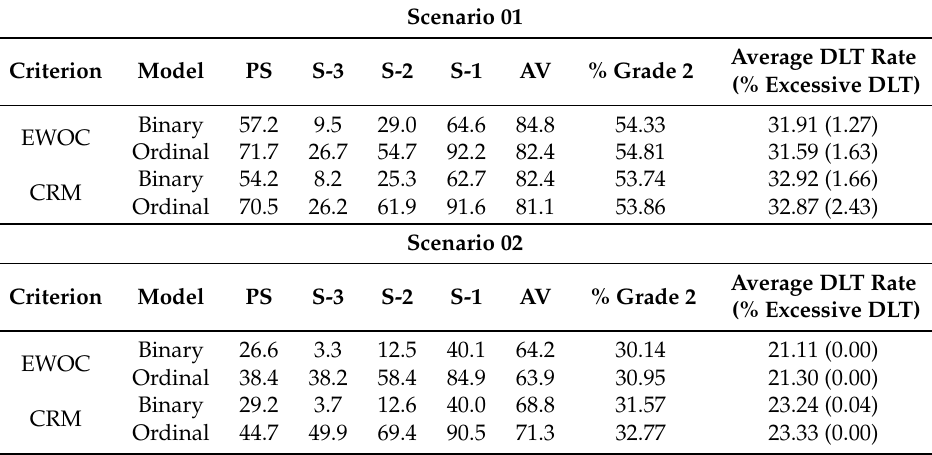
Table 3. Operating characteristics summarizing trial efficiency and safety for CRM and EWOC using non-informative